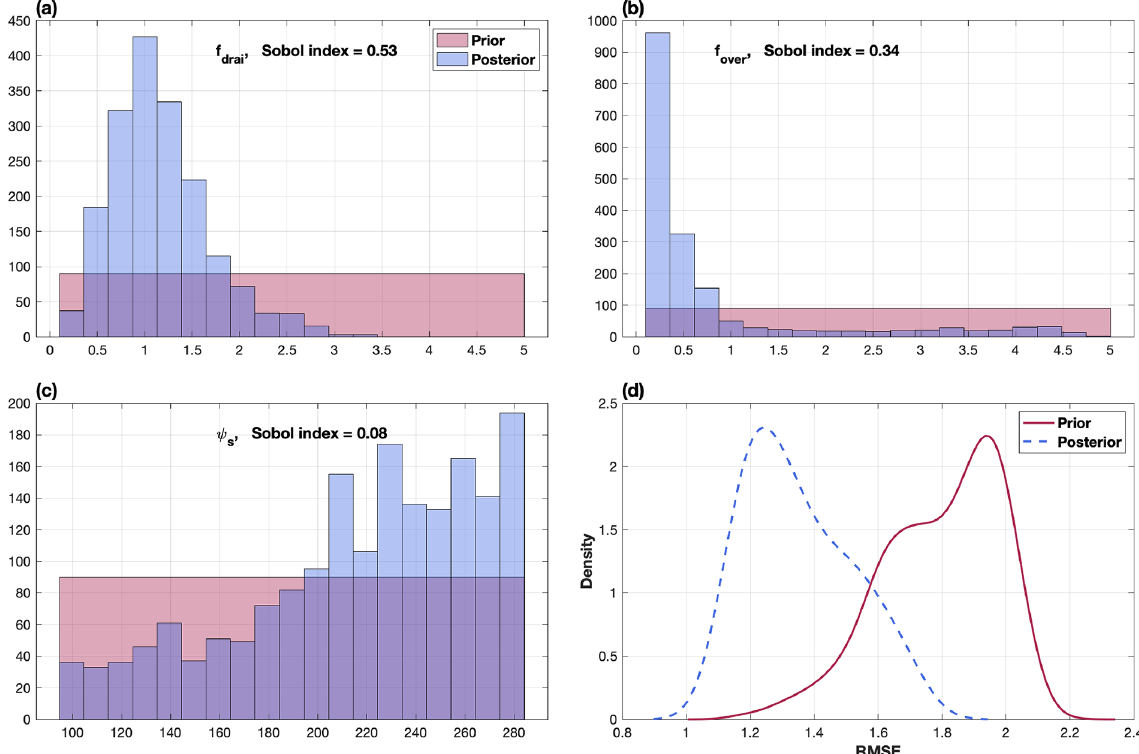
Figure 6. Posteriors of (a) f drai , (b) f over , and (c) ψ s from parameter inference process at an example grid cell. Panel (d) shows the probability density function (PDF) of RMSE evaluated with surrogate models forced by 100 samples from parameter posteriors and 10000 samples from parameter